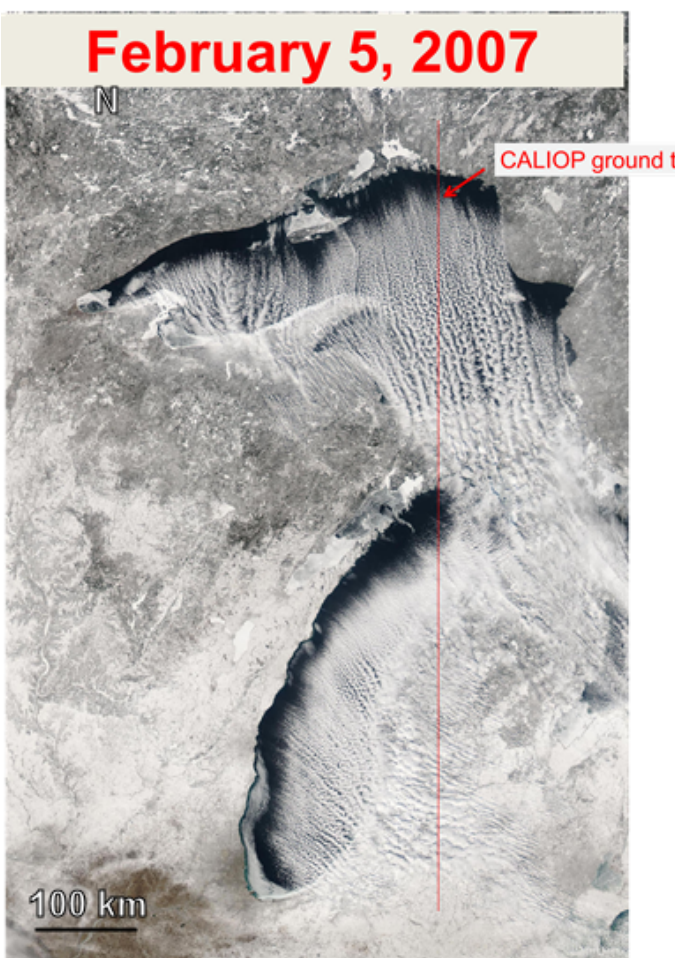
Figure 11. A polar air mass flowing over Lake Superior and Lake Michigan on 5 February 2007 generating wind parallel cloud bands over Lakes Superior and Michigan. The thin red line indicates the sampling region of the Cloud-Aerosol Lidar with Orthogonal Polarization